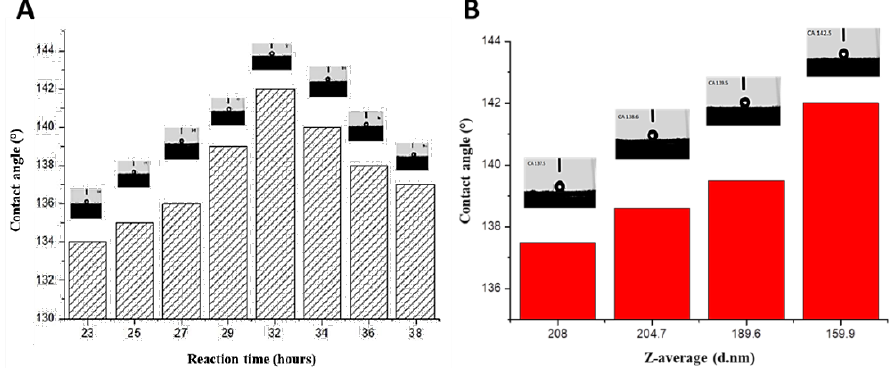
Figure 2. Effect of the reaction time ( A ) and the size of PMMA nanoparticles ( B ) on the contact angle of the modified fabric cotton